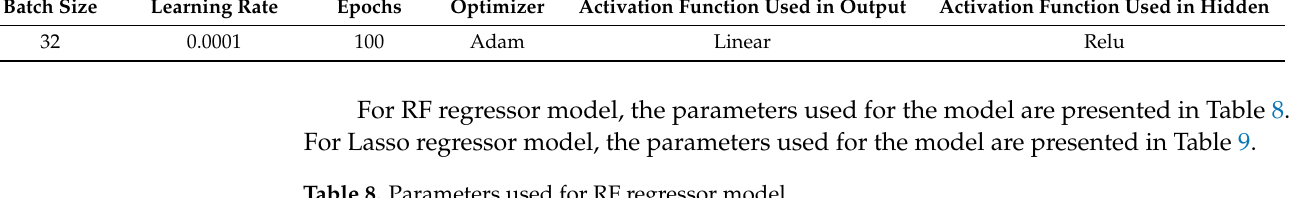
Table 8. Parameters used for RF regressor model.